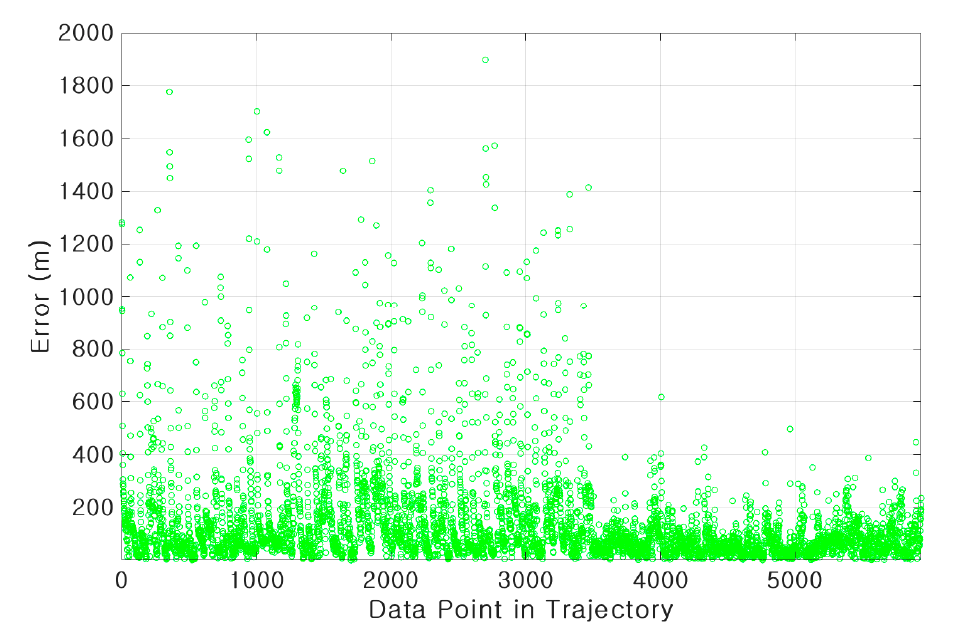
( f ) Error scatter plot for group A using GRU.